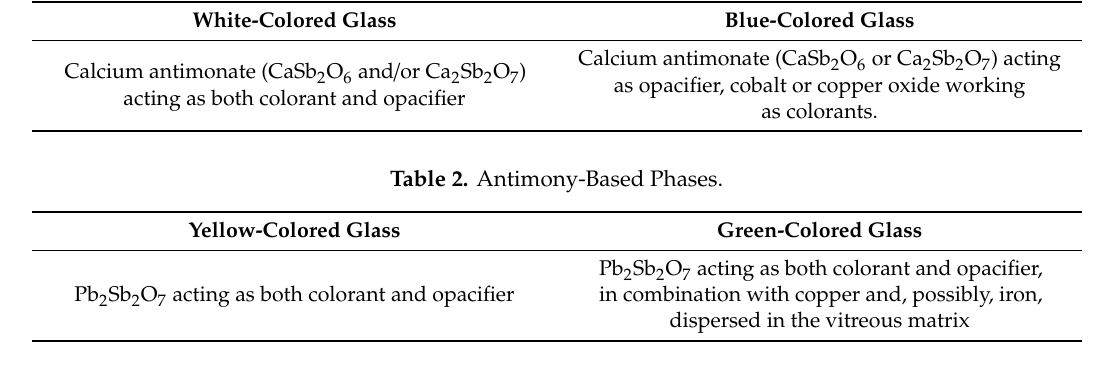
Table 3. Lead–Tin–Antimony-based phases.